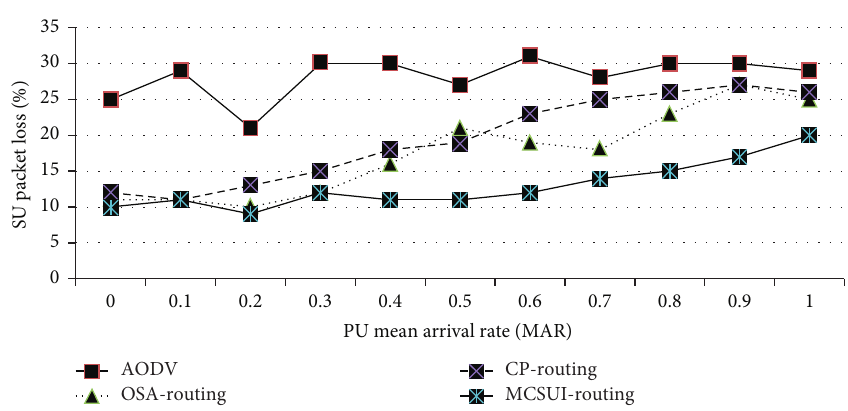
Figure 17: Packet loss of SU at PU’s sd of MAR � 0.8